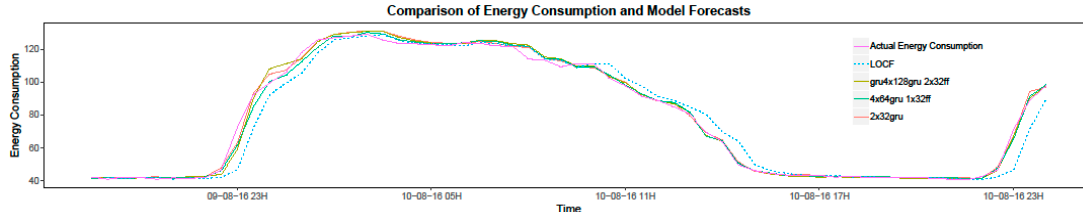
Figure 14. Performance of base models vs. LOCF benchmark; all the base model forecasts fit closer to the actual data than the LOCF forecast.